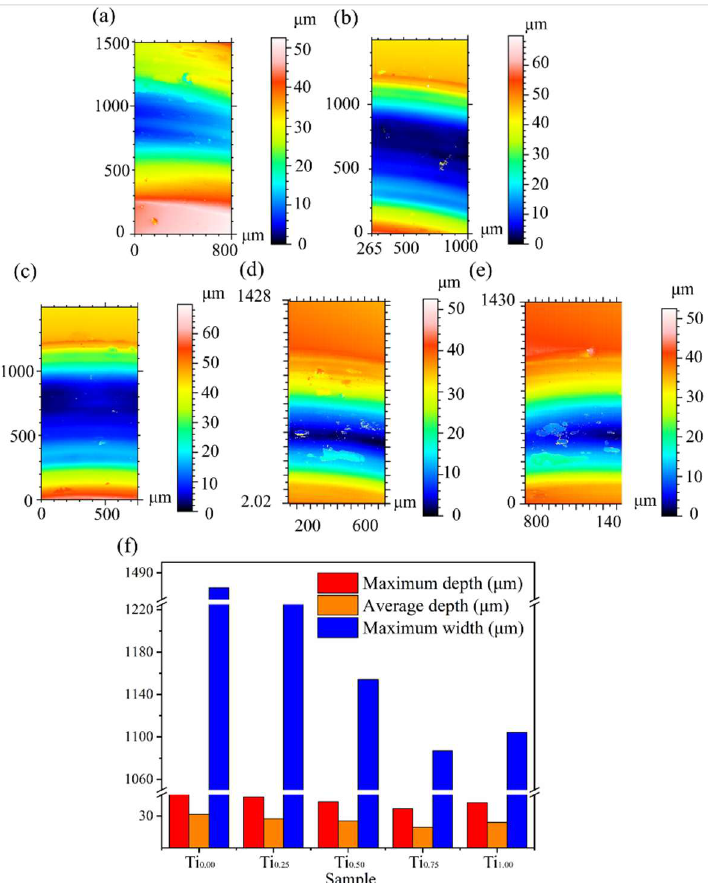
Figure 8. Three-dimensional contours topographies of the worn scars for the CoCrFeMnNiTi x HEA coatings: ( a ) Ti 0 , ( b ) Ti 0.25 , ( c ) Ti 0.5 , ( d ) Ti 0.75 , ( e ) Ti 1 , ( f ) maximum depth, average depth, and maximum width of the wear scar surface area.